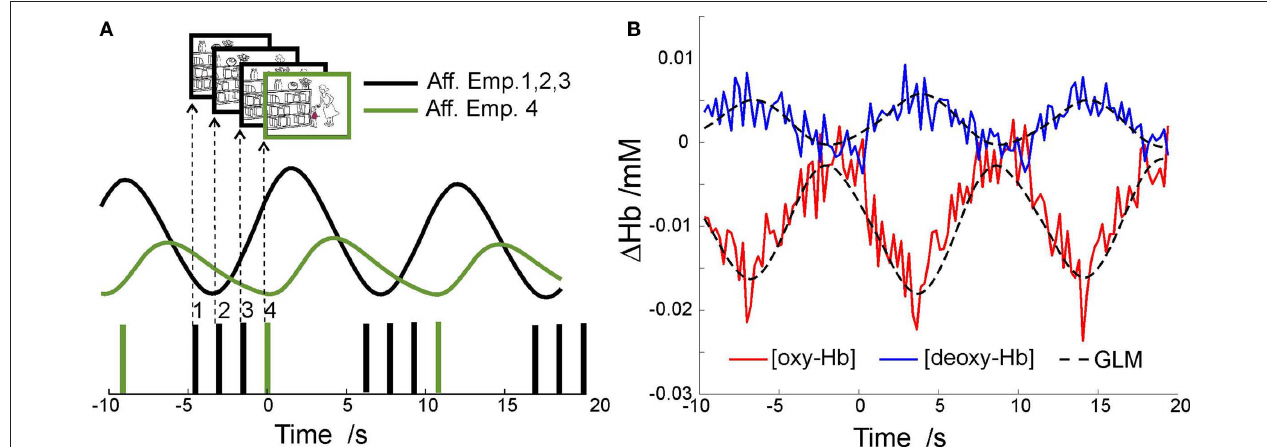
GLM-model. Note that the time courses show a relative deactivation for the visual affective empathy condition with decreasing [oxy-Hb] and increasing [deoxy-Hb] due to the superposition of the first three and the fourth cartoon slides. The relative deactivation of the lateral orbitofrontal regions during processing of the stories is in agreement with fMRI results on similar material (Hynes et al., 2006, Figure 2 ). Besides this overall deactivation during the processing of the empathy stories, activation was revealed for the respective contrasts (see results, Table 2